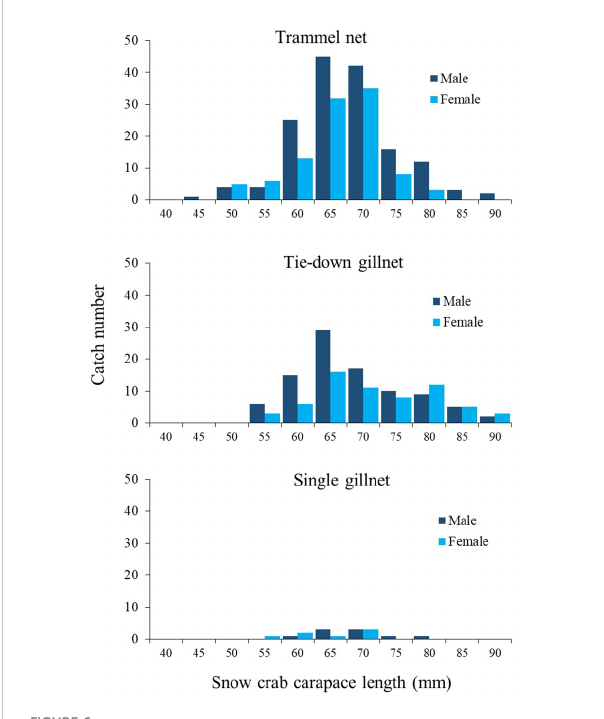
FIGURE 6 The distribution of the number of snow crabs caught in three different gillnets as a function of their carapace length.